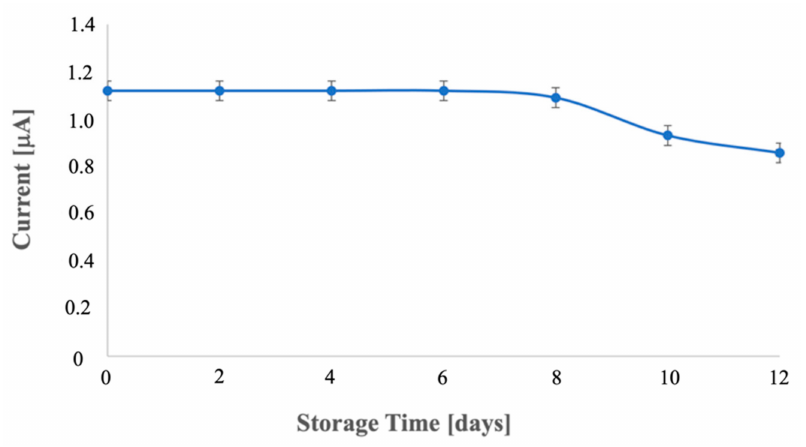
Figure 6. Storage stability of the immunosensor stored at 4 ◦ C over 12 days. Error bars are standard deviations of three measurements.